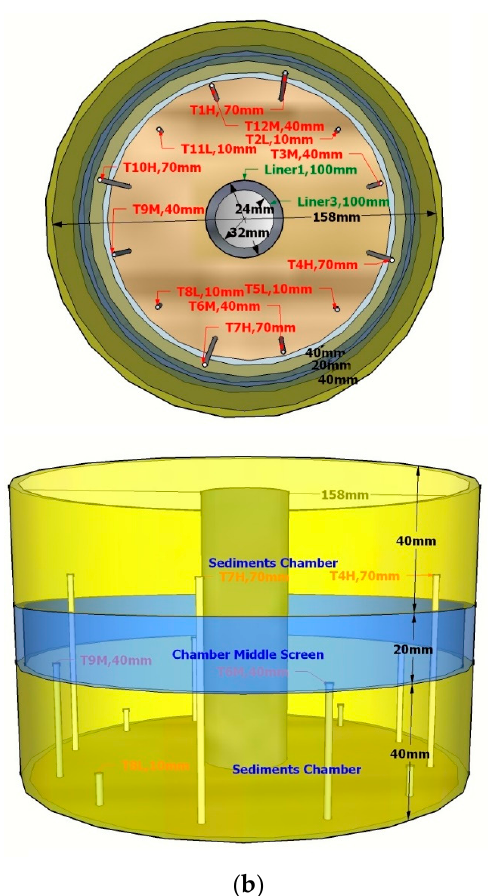
Figure 1. Schematic of methane hydrate sand production facility and the sediments chamber, ( a ) Schematic of methane hydrate sand production and sand prevention facility; ( b ) Top view and Flat view of sediment chamber (T indicates temperature, 1–12 indicates the alignment of the temperature sensors; H, L and M indicates the height of the temperature sensors in layers H (70 mm), M (40 mm) and L (10 mm)).